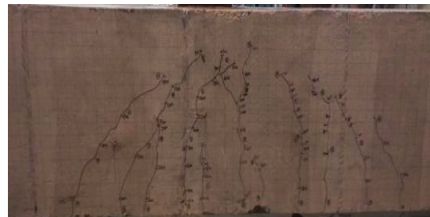
Figure 10: Crack diagram of south side.